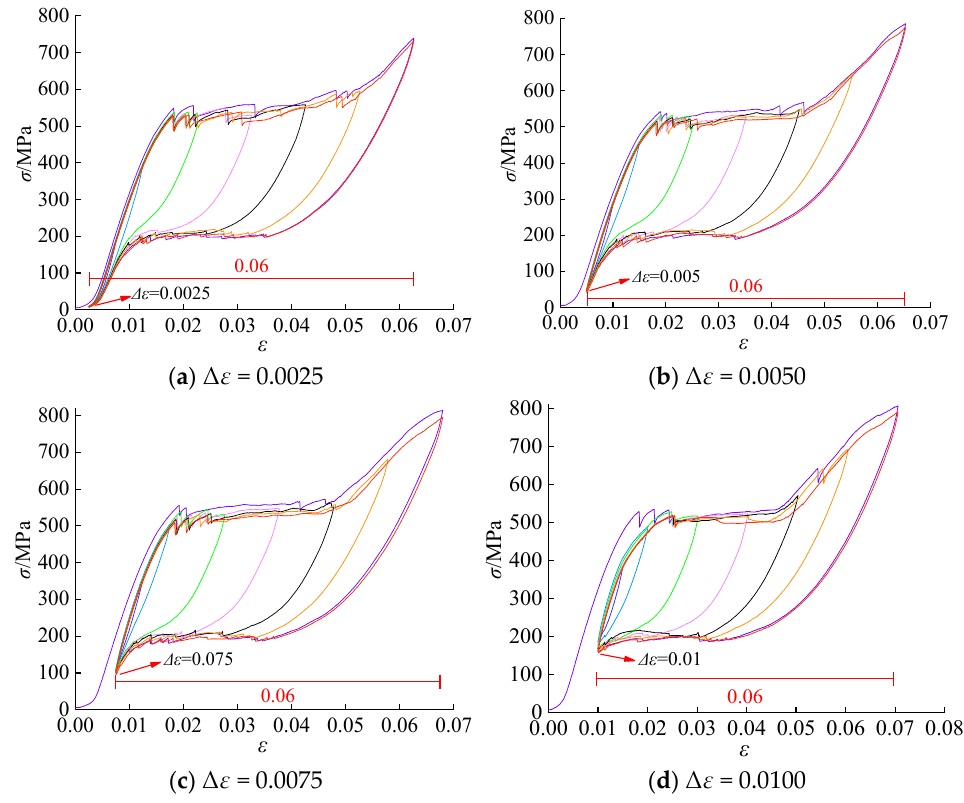
Figure 5. Effect of the initial strain on the hysteresis curve of the pre-tensioned SMA wire. The different energy dissipations of the pre-tensioned SMA wires is shown in Figure 6a. An increment of E i for the SMA wires with an increase in ∆ ε from 0.0025 to 0.0075 can be obviously observed under different strain amplitudes, which has mainly been caused by the increment of the hysteresis areas. Then, the energy dissipation capabil- ity for a 0.0075 initial strain is stronger than that of a 0.0100 initial strain; it can be